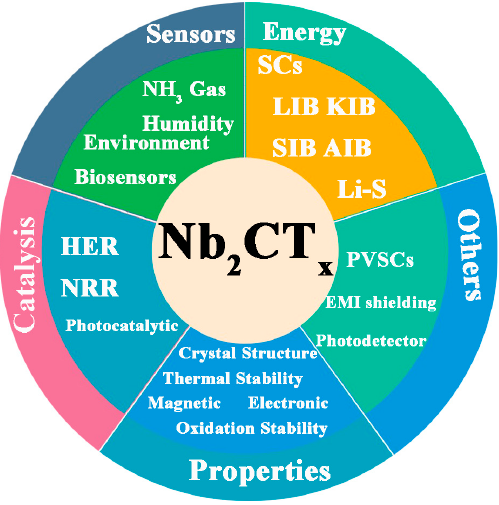
Figure 1. Di ff erent properties and applications of Nb 2 CT x . Figure 1. Different properties and applications of Nb